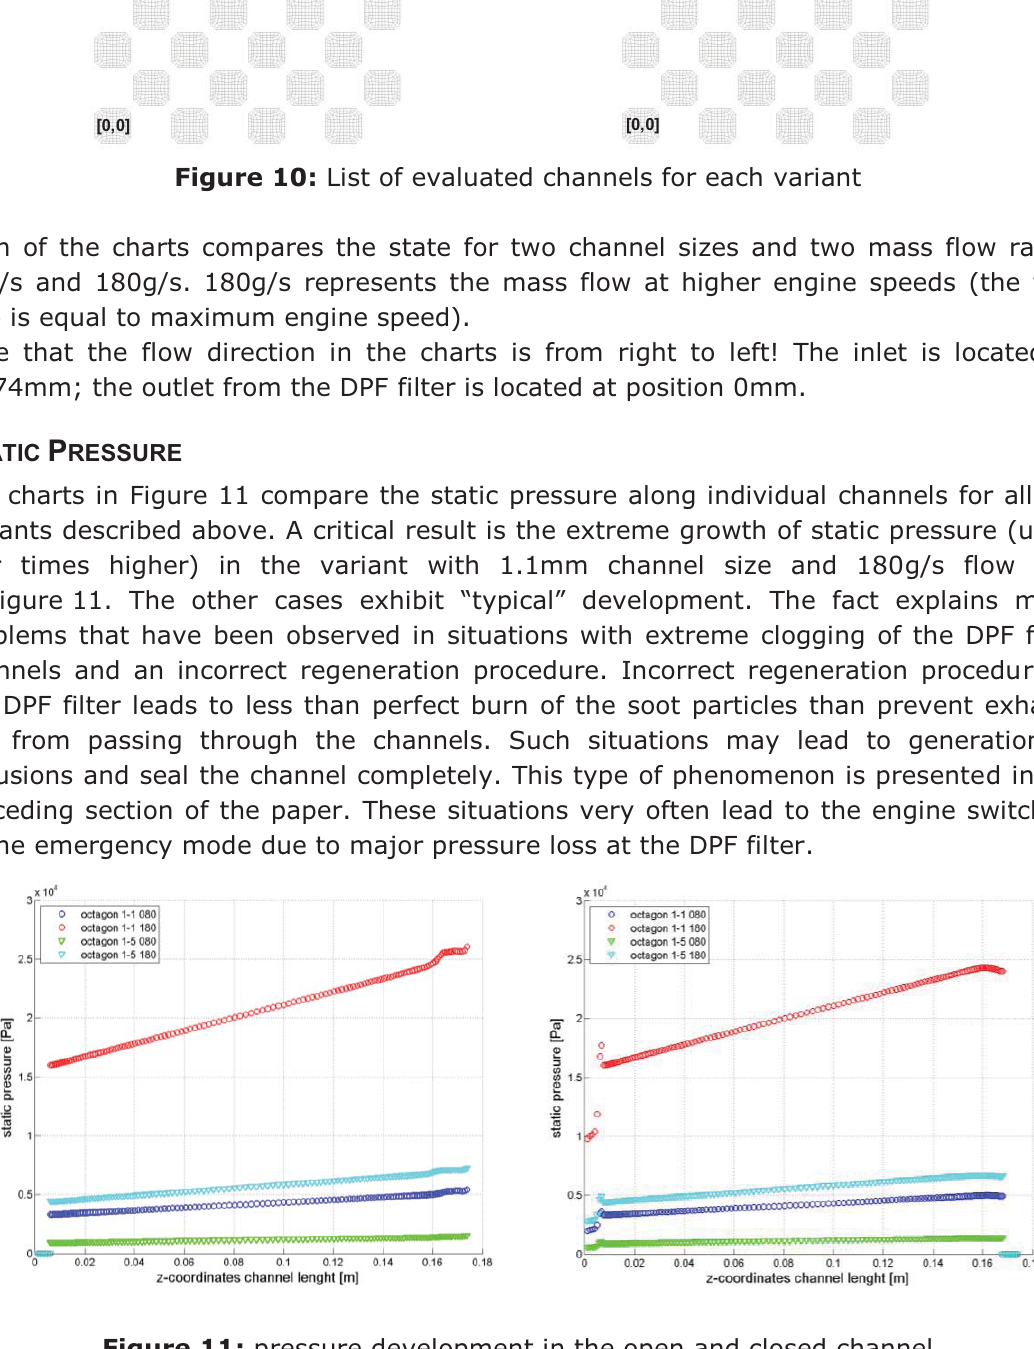
Figure 11: pressure development in the open and closed